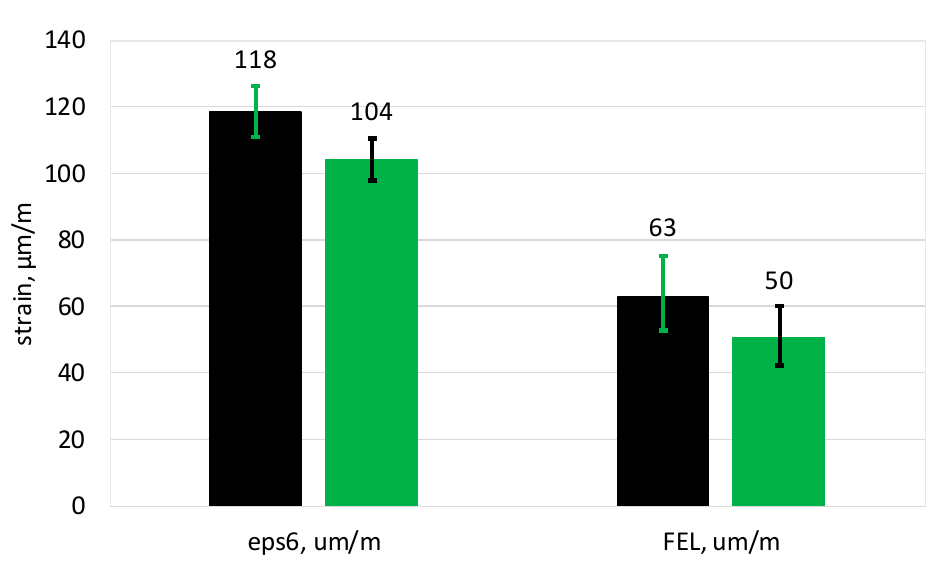
Figure 5. Comparison of fatigue strains ( ε 6 and FEL).